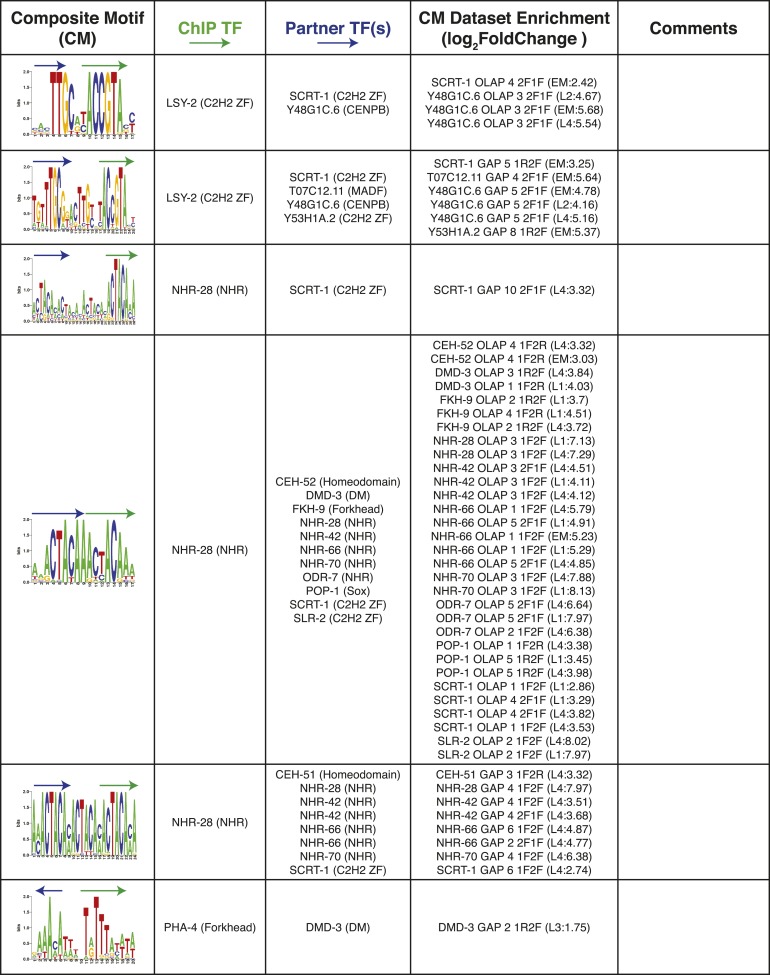
Summary of clustered CMs enriched in C. elegans ChIP-seq peaks (continued).CM-cluster centroids are shown for the enriched motifs. For each cluster, the ChIPed TF(s) and potential partner TF(s) are listed along with information about motif overlap (OLAP), spacing (GAP), and enrichment. Colored arrows over motif indicate high-information content portions of either factor.